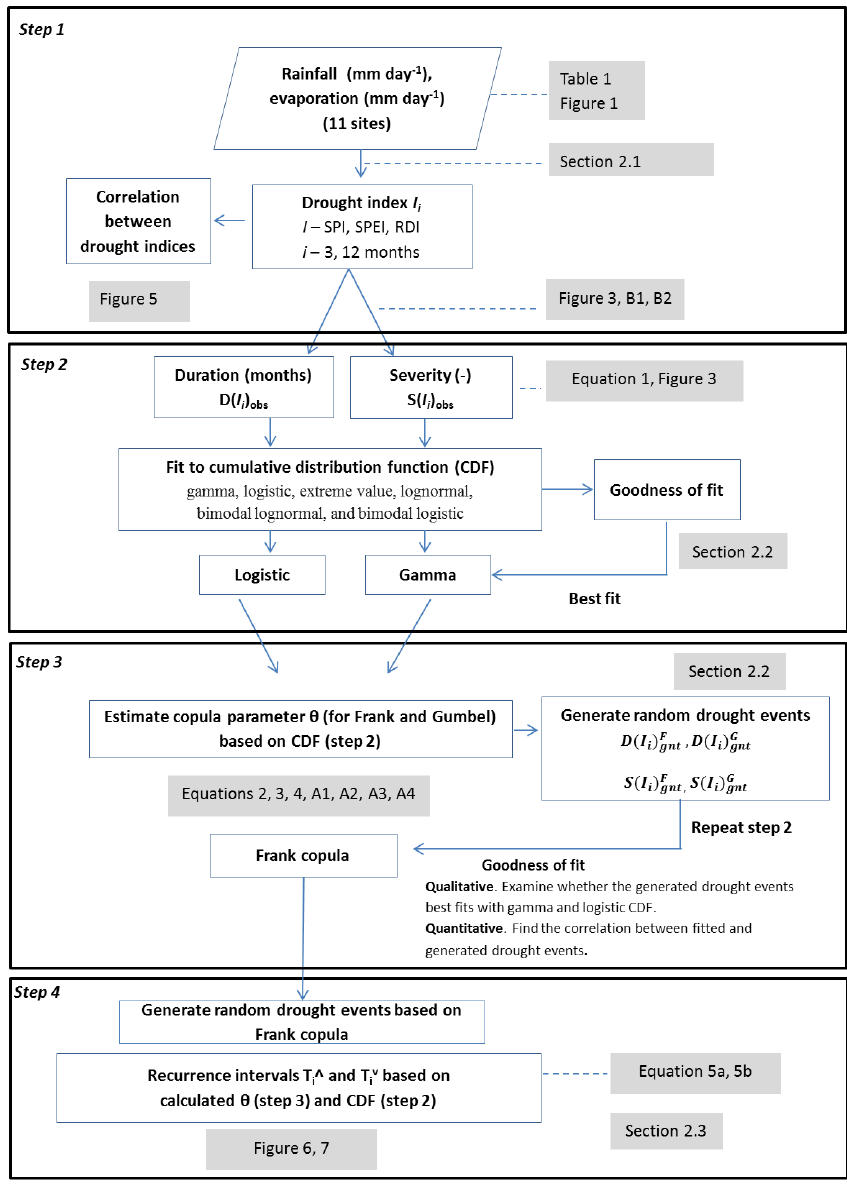
Figure 2. Schematic diagram of steps applied to estimate recurrence intervals of drought events. See Sect. 2 for further details. Step 1: calculate drought index based on monthly rainfall (SPI) and evaporation (RDI, SPEI). Step 2: fit cumulative distribution function (CDF) to estimated drought duration and severity. Step 3: estimate copula parameter based on CDFs. Step 4: calculate recurrence intervals based on CDFs of univariate (severity, duration) distributions and bivariate joint distribution